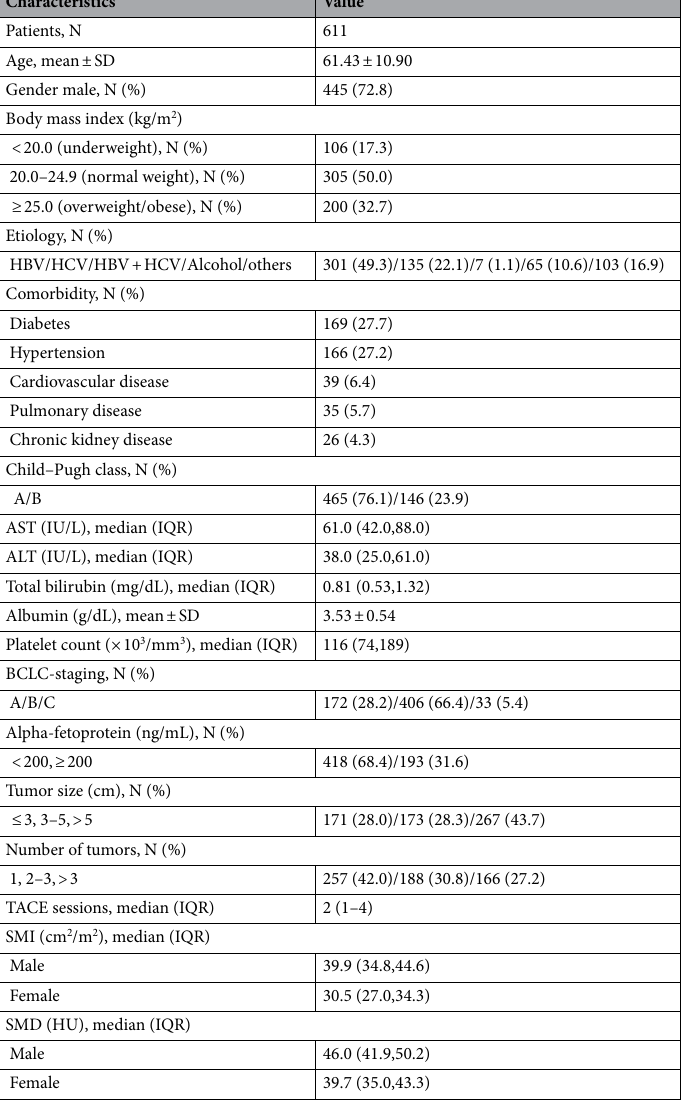
The overall all-cause mortality rate at seven years following TACE was 87.13%. Patients with myosteatosis had a higher rate of mortality than patients without myosteatosis (93.18% vs. 83.58%, P < 0.0001) (Fig. 3). The rates of 7-year all-cause mortality were 90.2% and 85.59% in patients with and without sarcopenia, respec- tively ( P = 0.011). In the multivariable Cox regression analysis, patients with myosteatosis or sarcopenia had a higher risk of all-cause mortality than their counterparts (adjusted hazard ratio [HR] for myosteatosis versus no myosteatosis 1.66, 95% CI 1.37–2.01, adjusted HR for sarcopenia versus no sarcopenia 1.26, 95% CI 1.04–1.52). Patients in group D (myosteatosis and sarcopenia) had the highest mortality rate at seven years (94.45%), whereas group A (neither myosteatosis nor sarcopenia) had the lowest mortality rate (83.31%) (Fig. 4). The mor- tality rate was 84.82% in group B (sarcopenia without myosteatosis) while it was 91.62% in group C (myosteatosis without sarcopenia). The all-cause mortality rate was significantly different among the four groups ( P < 0.0001). Compared with group A, the adjusted risk for all-cause mortality was significantly higher in group C (adjusted HR 1.70, 95% CI 1.33–2.17) and group D (adjusted HR 1.75, 95% CI 1.36–2.23). The risk of all-cause mortality in group B was similar to group A (adjusted HR 1.19, 95% CI 0.90–1.57).